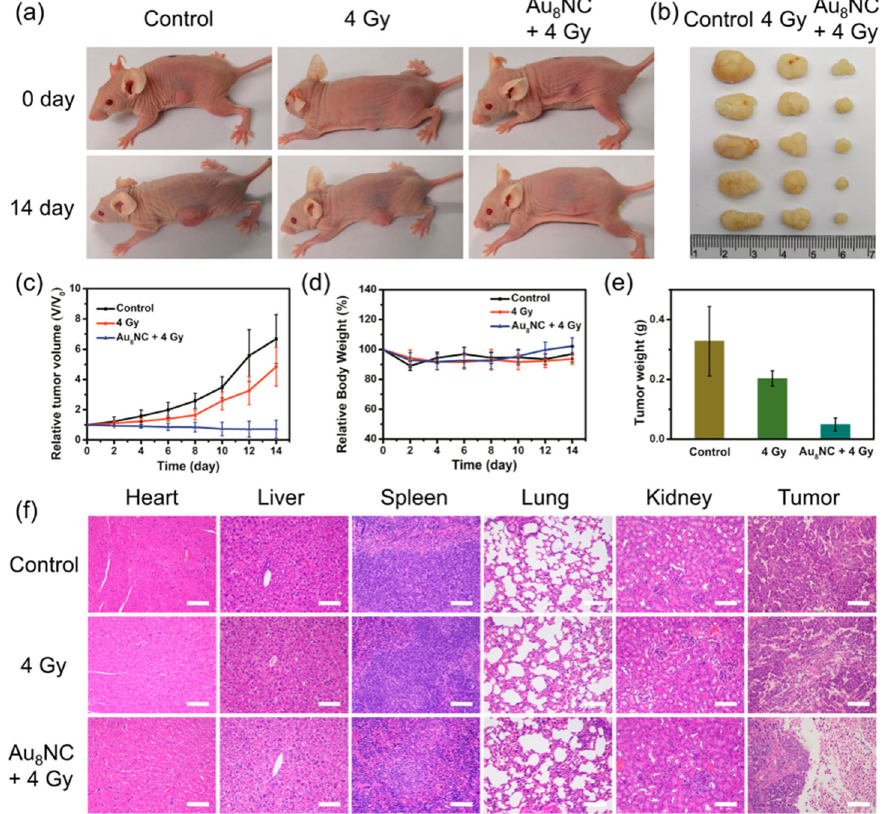
Figure 4. In vivo tumor assay of Au 8 nanoclusters. ( a ) Typical images of mice under different conditions at 0 and 14 days. ( b ) Photos of dissected tumors. ( c ) Relative tumor volume curves. ( d ) The curves of relative mice body growth. ( e ) The tumor weights. ( f ) H&E histological staining of excised organs and tumor slices. X-ray irradiation energy: 6 MV. Reprinted with permission from [100]. Copyright 2019, American Chemical Society.